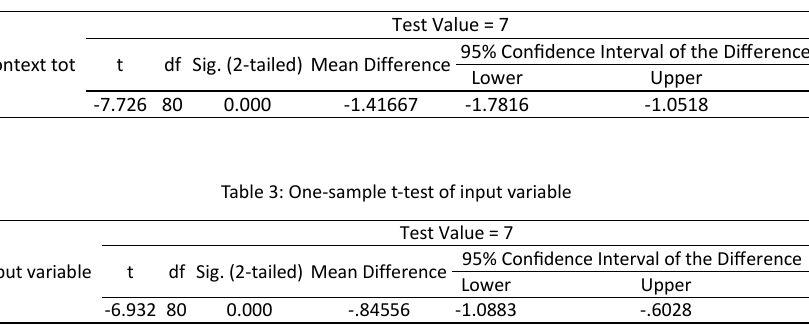
Table 2: One-sample t-test of context variable